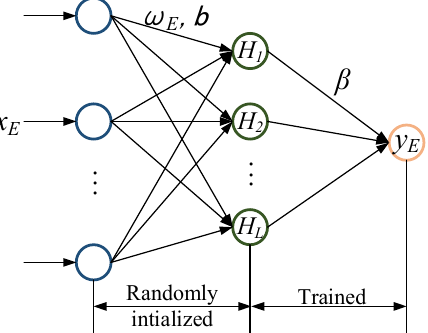
Figure 1. Topological structure of ELM.